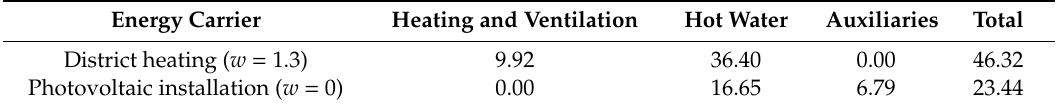
Table 24. The annual EK demand (kWh / (m 2 · year)) for the multi-family building at Akacjowa Street in Goleniow (district heating (Goleniow) + application of photovoltaic installation (max 68 kWp) for supplying auxiliary equipment and partially for hot water preparation + mechanical ventilation with recovery).